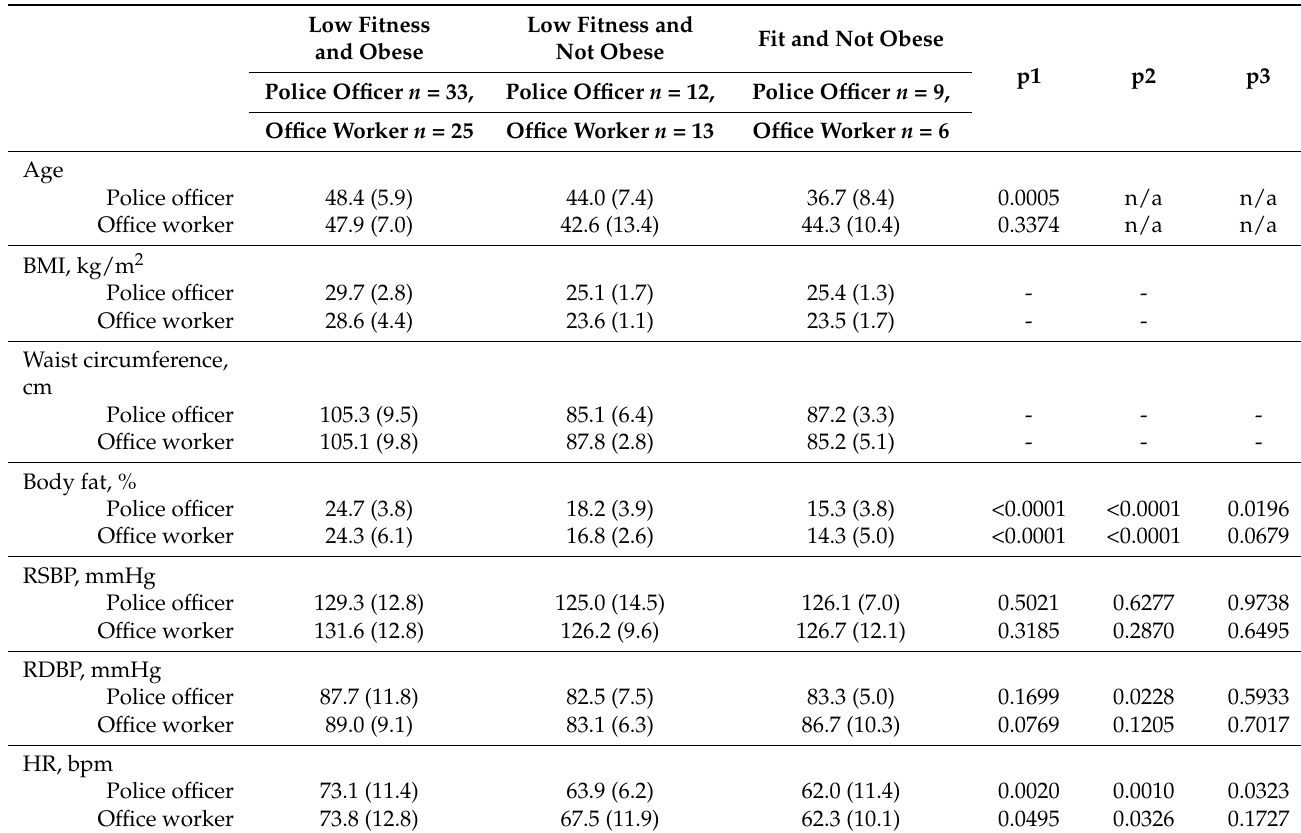
Table 3. Participants (police officers and office workers) divided by METs and BMI in four different level groups (mean and